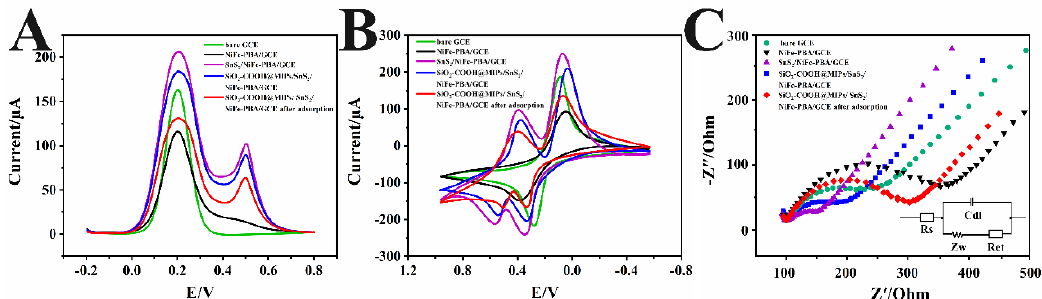
Figure 2. ( A ) DPV, ( B ) CV, and ( C ) EIS curves of electrode surfaces modified with different materials. Electrochemical measurements were performed in solutions containing 5 mmol/L[Fe(CN) 6 ] 3-/4- and 0.1 mol/L KCl.